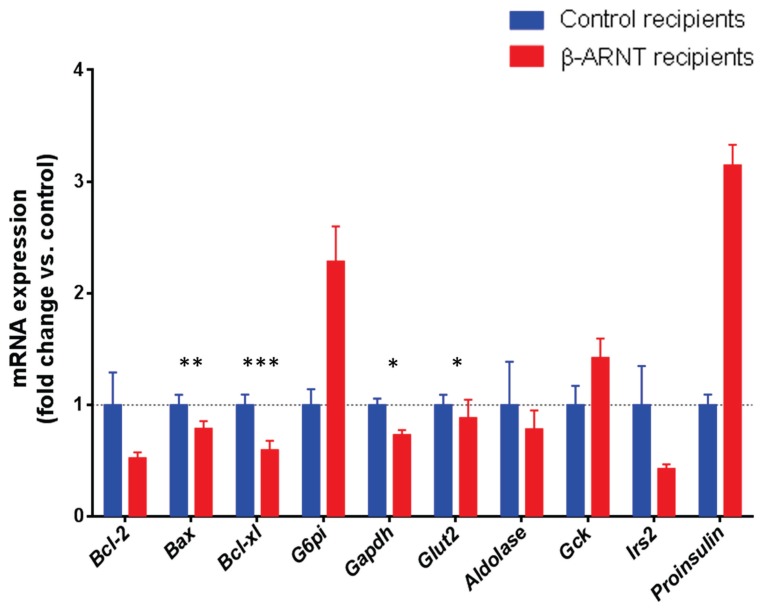
Gene expression changes in β-ARNT and control grafts.β-ARNT recipients (red bars) had a decrease in Bcl-xl, Bax, Glut2 and Gapdh expression, a tendency to decreased Irs2, and to increased Proinsulin and Gck expression, as compared to the floxed control recipients (blue bars) (n = 7–8 per group). (*** = p<0.001, ** = p<0.01, * = p<0.05). Data are presented as means ± SEMs.